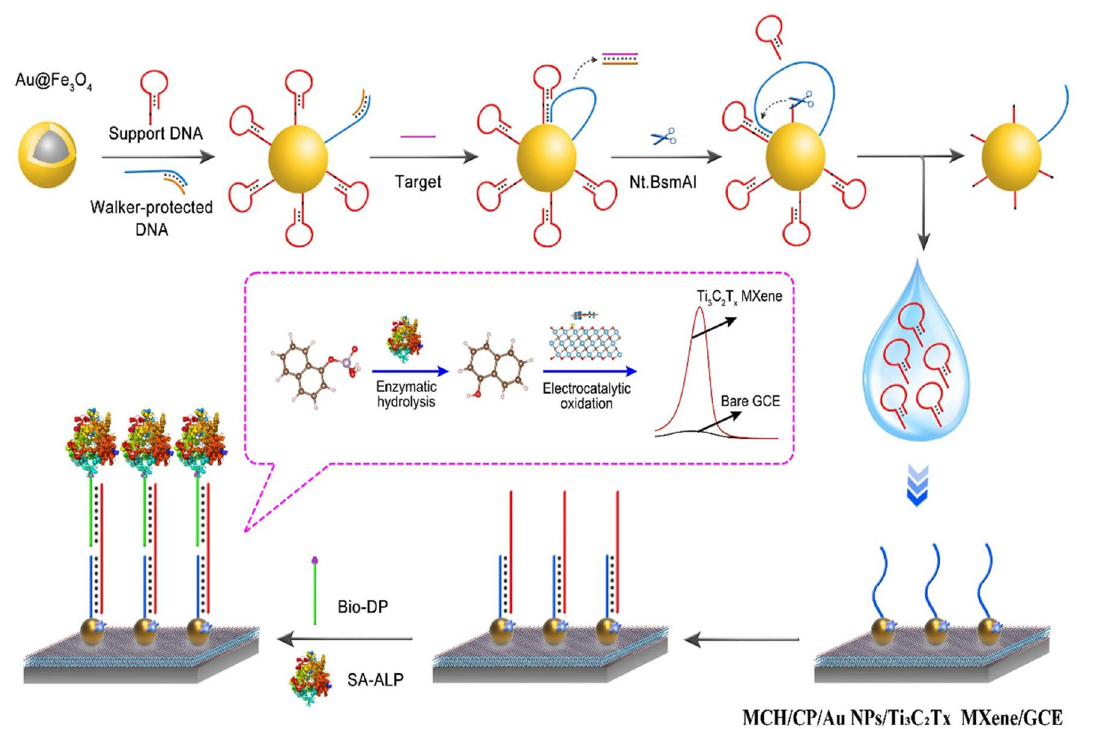
Fig. 4 The working principles of an electrochemical biosensor constructed from 6-mercaptohexanol (MCH), Au NPs, MXene (Ti 3 C 2 T x ), and glassy carbon electrode (GCE). Nt.BsmAI nicking endonuclease (Nt.BsmAI). Reproduced with permission from Ref. [65]. Copyright 2022 Springer Nature (CC